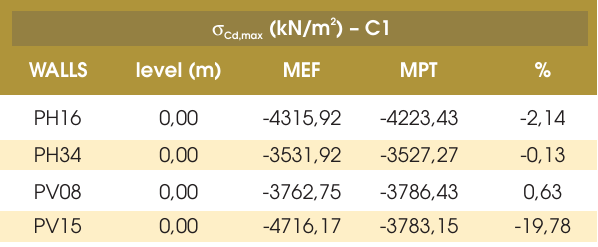
Table 7 – Comparison of the maximum normal stress of compression obtained by both models